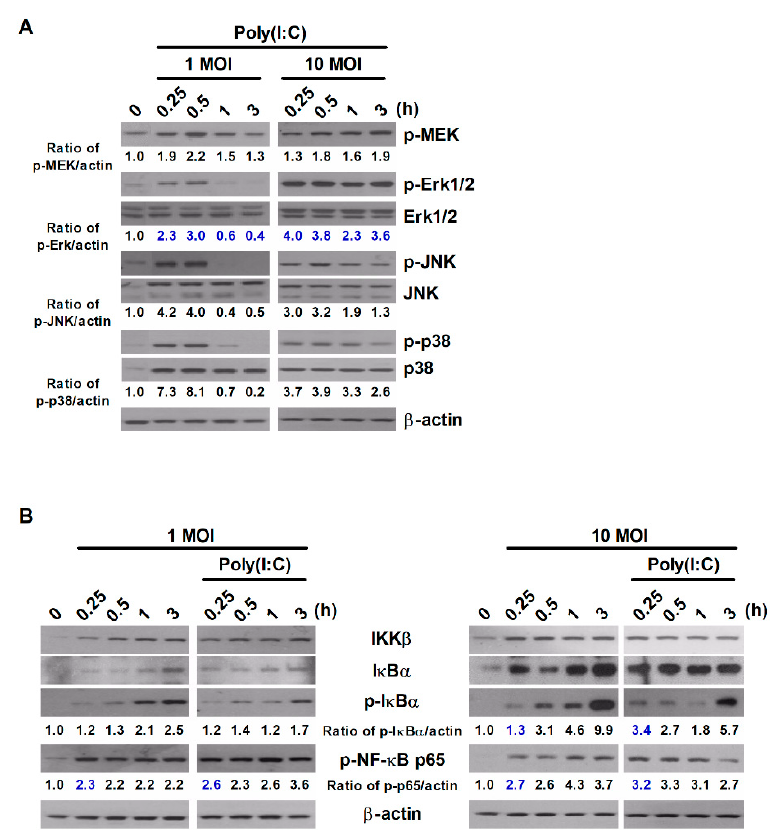
Figure 2. Poly(I:C) enhances the activation of MAPK and NF- κ B signaling in S . Typhimurium-infected cells. RAW264.7 cells were infected with S . Typhimurium at an MOI of 1 or 10 and then treated with poly(I:C) (10 μ g/mL) for the indicated durations. Total cell lysates were assessed via Western blot analysis to detect the expression of ( A ) MAPK-related proteins and ( B ) NF- κ B-related proteins. Band intensities for phosphorylated proteins were quantified using ImageJ software and normalized to β -actin. Fold changes are indicated at the bottom of each lane.